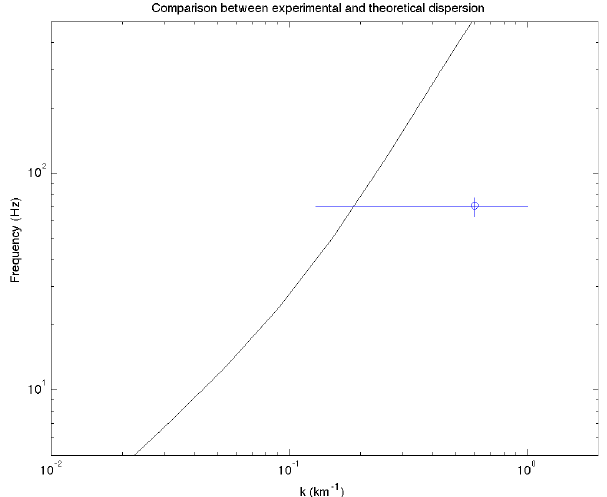
Fig. 6. Comparison of experimental and theoretical